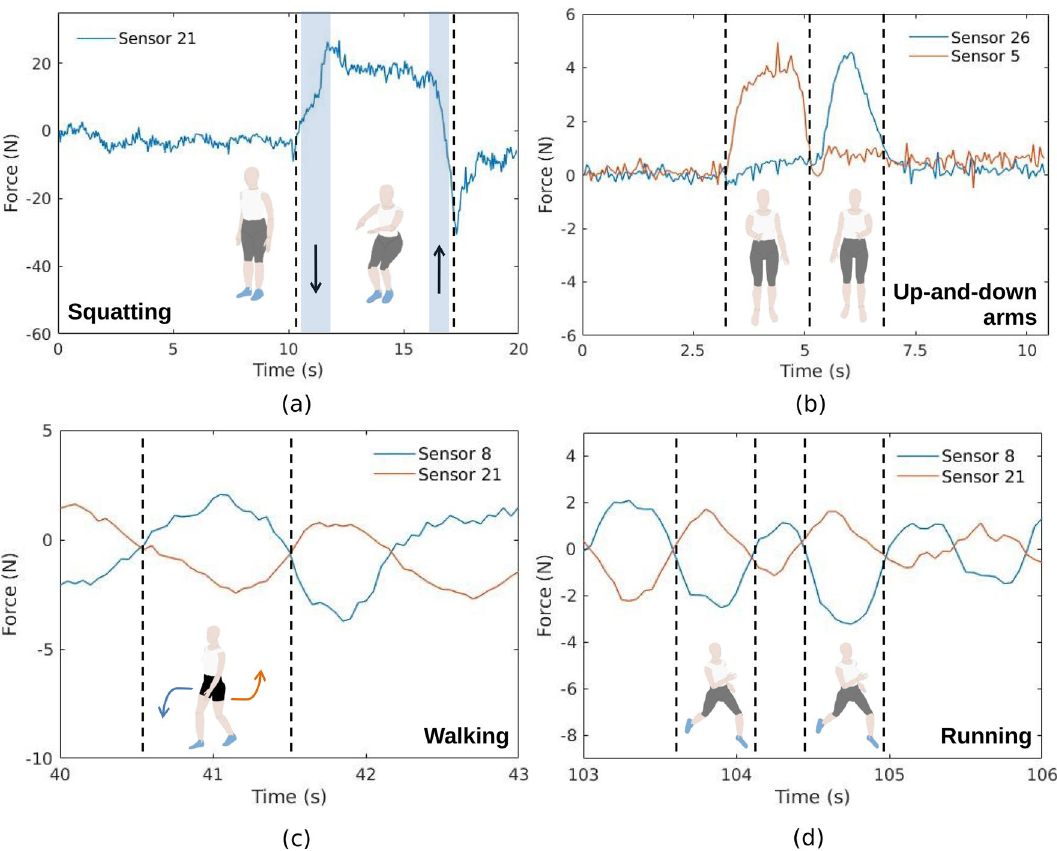
Figure 6. Mechanical analysis of different sensors during body moving in the different dynamic activities. ( a ) Squatting. ( b ) Up-and-down arms. ( c ) Walking. ( d )